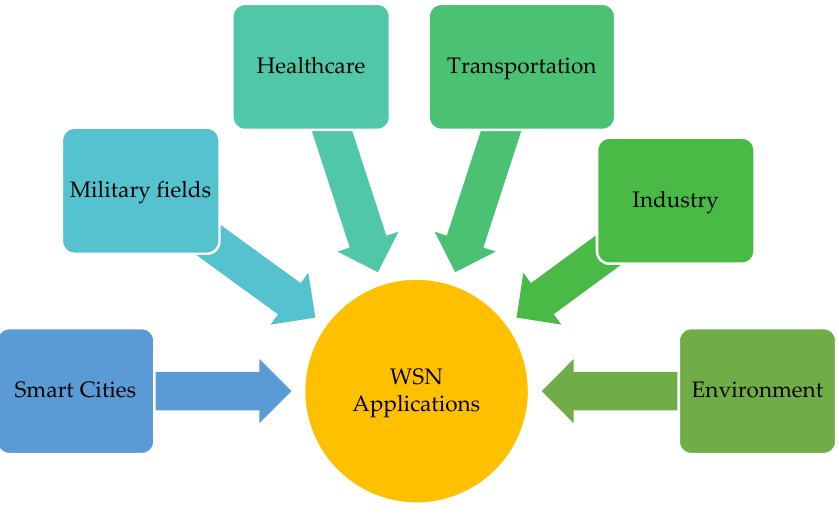
Figure 1. WSN application areas.